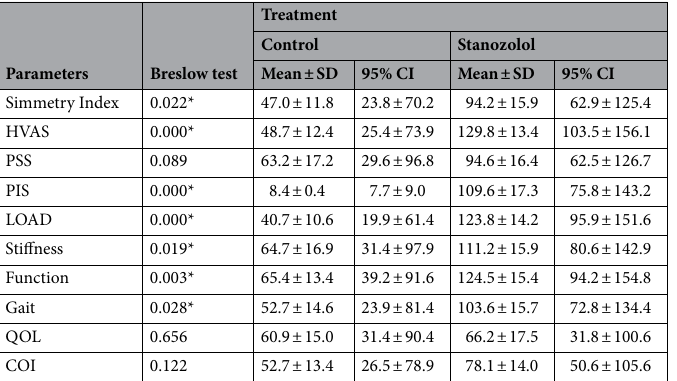
Table 4. Time to return to baseline values for SI and CMIs, calculated with Kaplan–Meier estimators and compared with the Breslow test. *Indicates